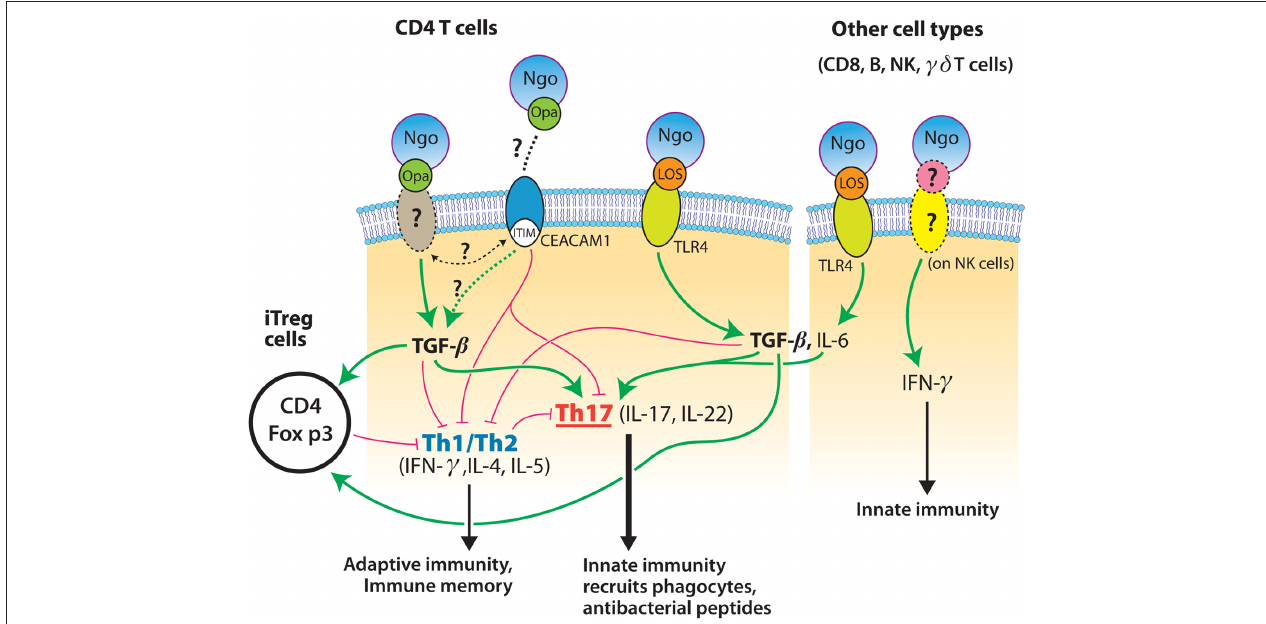
with CEACAM1 on human cells), leading to the increased production of TGF- β , which directly suppresses Th1 and Th2 cells, and also enhances the development of Treg cells which regulate Th1 and Th2 cells. Blockade of TGF- β thus relieves the suppression of Th1 and Th2 cells, which then drive adaptive immune responses, leading to memory, and